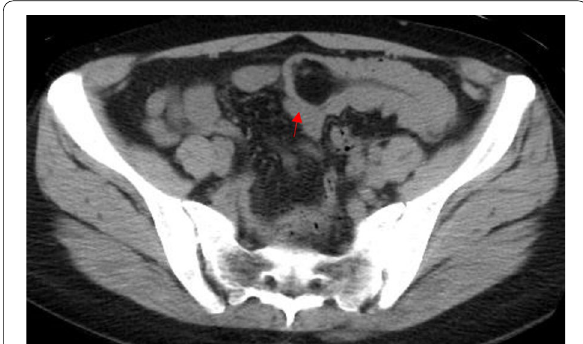
Fig. 1 CT scans of the abdomen. A fatty mass (indicated by the red arrow), 36 mm in diameter, with a long peduncle was found in the small intestine. The pseudo-kidney sign was noted, and intussusception appeared to be